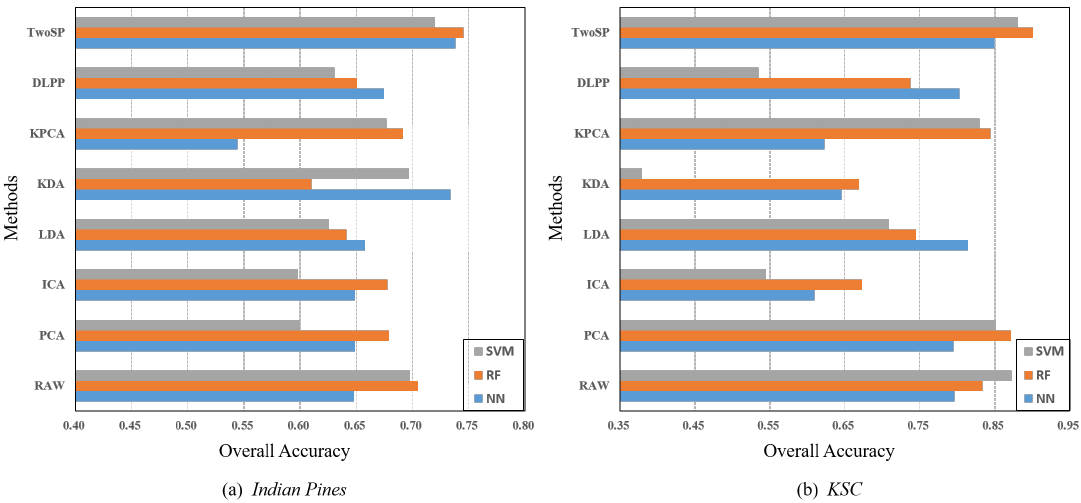
Figure 4. Classification Results in terms of Overall Accuracy (OA) of each dimensionality reduction method with different classifiers on ( a ) Indian Pines and ( b ) KSC